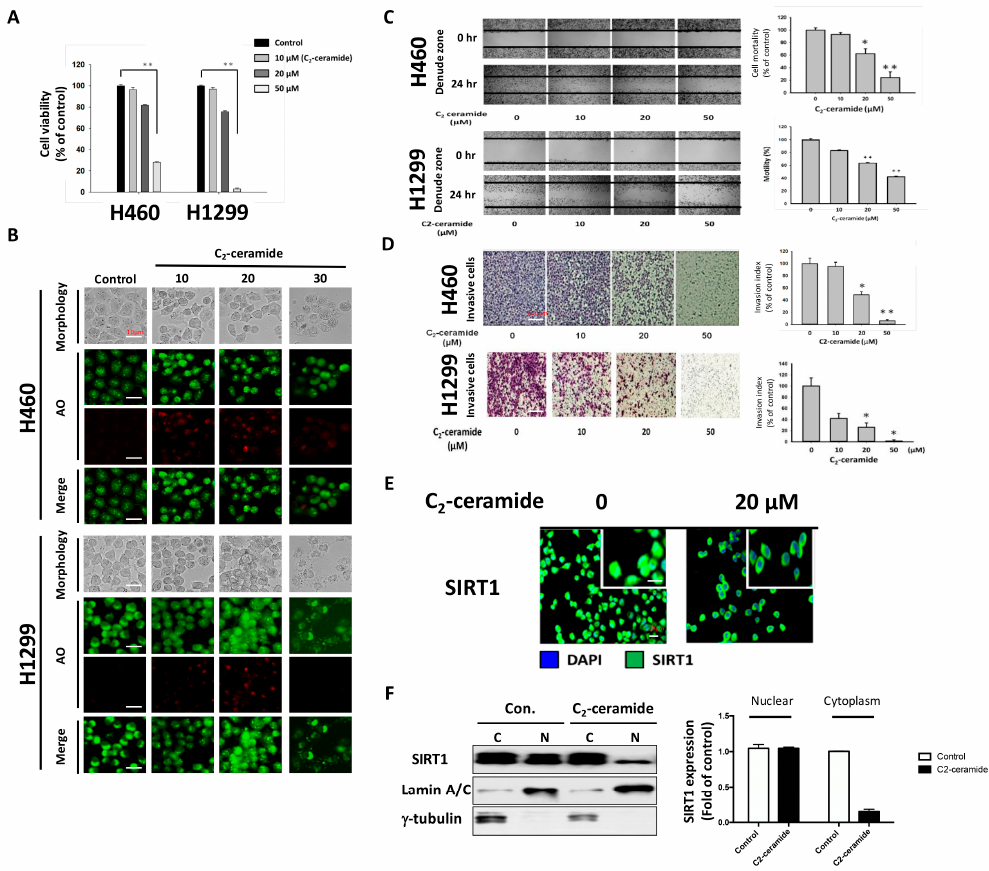
Figure 1. Cytotoxicity and autophagy induced by C 2 -ceramide in H460 and H1299 non-small cell lung cancer (NSCLC) cell lines. ( A ) C 2 -Ceramide induced cytotoxicity in H460 and H1299 cells in a dose-dependent manner after 24-h treatment. ( B ) Representative micrographs of acridine orange (AO) staining of H460 and H1299 cells after treatment with increasing concentrations of C 2 -ceramide for 24 h (BF for morphology; red for autophagy-positive cells). ( C ) Cell wound-healing assay of H460 and H1299 cells with increasing concentrations of C 2 -ceramide treatment for 24 h. (4× Magnification) ( D ) Cell invasion assay of H460 and H1299 cells treated with increasing concentrations of C 2 -ceramide for 24 h. Right panel: quantitative results. ( E ) Immunofluorescence staining of autophagy-related SIRT1 expression (green) in H460 cells after treatment with 20 µM C 2 -ceramide for 12 and 24 h. ( F ) Western blot analysis of SIRT1 expression in cytoplasmic and nuclear fractionations. H460 cells were treated with 20 µM C 2 -ceramide for 24 h, with γ -tubulin as the cytoplasm internal control and Lamin A/C as the nuclear internal marker. Right panel: quantitative results of altered SIRT1 expression by C 2 -ceramide in the nucleus and cytoplasm. The data are presented as the means ± standard deviation (SD) of three independent experiments. * p < 0.05; ** p < 0.001 treated cells versus the control.